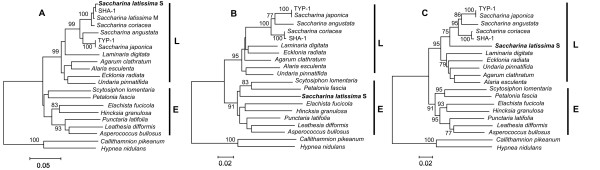
Phylogenetic trees based on different fragments of the COI coding region: (A) 5’- COI , (B) 3’- COI , and (C) full COI region.  Representative sequences of the orders Laminariales (L) and Ectocarpales (E) included in these trees are marked by vertical lines. Red algae COI sequences of Callithamnion pikeanum and Hypnea nidulans (GenBank accession numbers EU194965 and FJ694907, respectively) are used as outgroups. Note the changed position of S. latissima (in bold) depending on the COI region used for the tree. The S. latissima COI sequence denoted as “S” is from [2]. See Additional file 3 for GenBank accession numbers. Other comments as in Table 1 and Figure 3.